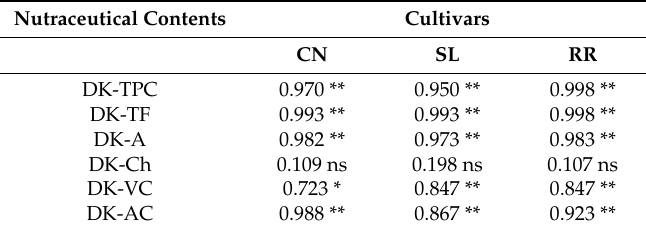
Table 4. Determination coefficients ( R 2 ) between doses of K + (DK) and nutraceutical contents in cultivars of hydroponic basil.